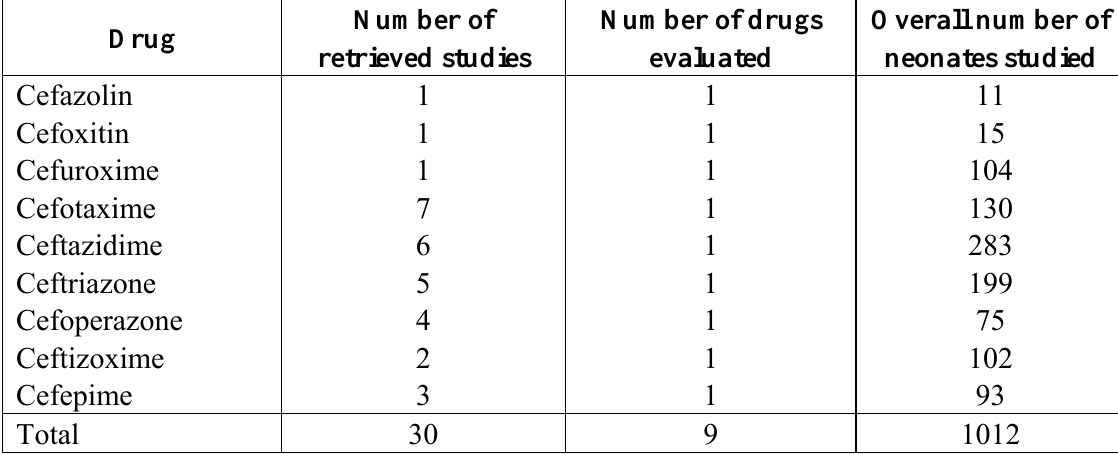
Table 3 . Number of retrieved studies and number of drugs